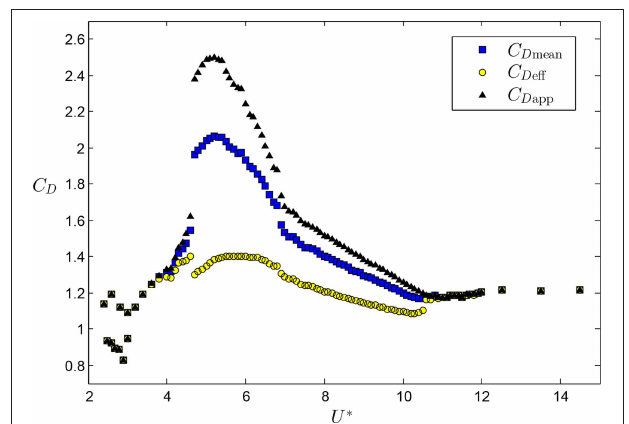
FIGURE 11 | Variation of the mean magnitude of the unsteady lift, C L , with the combined parameter A ∗ / ( U ∗ S ) 2 . The solid line is a best linear fit to all our data that are indicated by the symbols, from VIV measurements in water. The dashed line is an empirical expression developed by Diana and Falco [ 19] from VIV measurements in air.